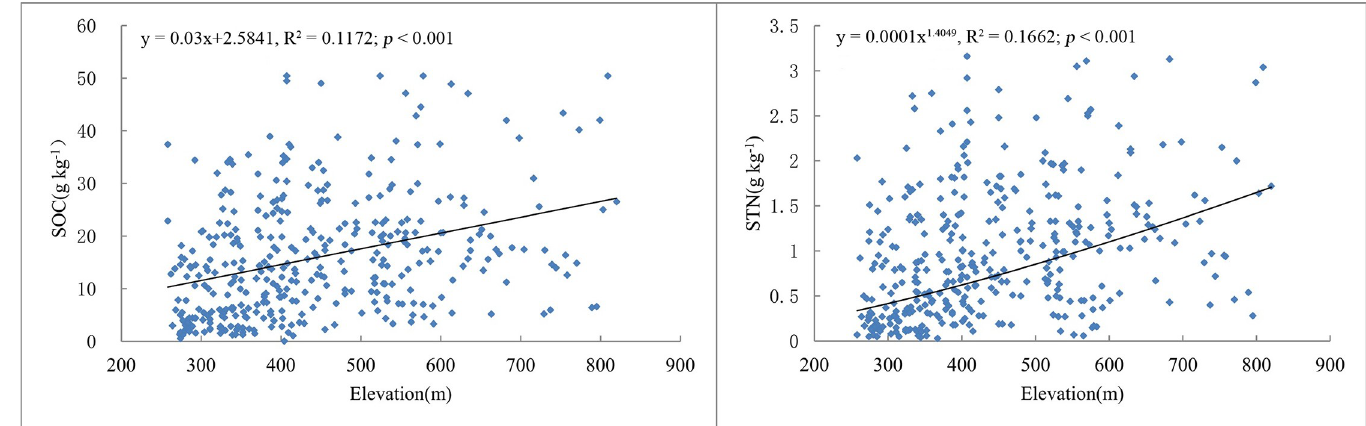
Fig 5. Regression analyses between SOC, STN, and elevation using scatter